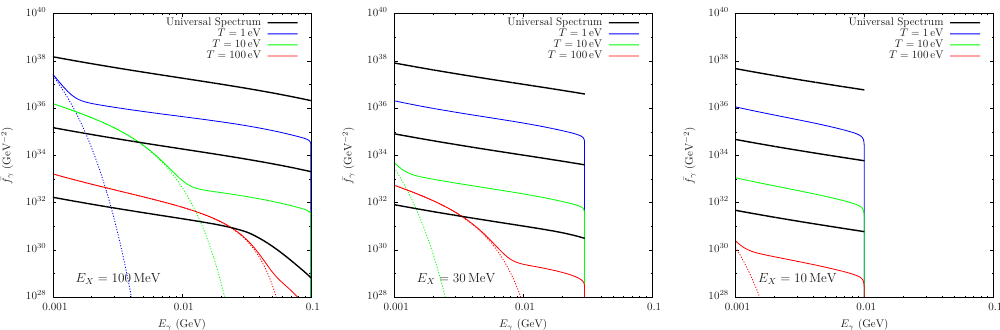
+ e Figure 3 . Photon spectrum (cid:22) f (cid:0) ) injection with energies E X = (cid:13) ( E ) for electron plus positron ( e 100 MeV (left), 30 MeV (middle), and 10 MeV (right), with T = 1 ; 10 ; 100 eV. The solid lines show the full spectrum, while the dashed lines show the result when FSR is not taken into account. Also shown is the universal spectrum for the same total injected